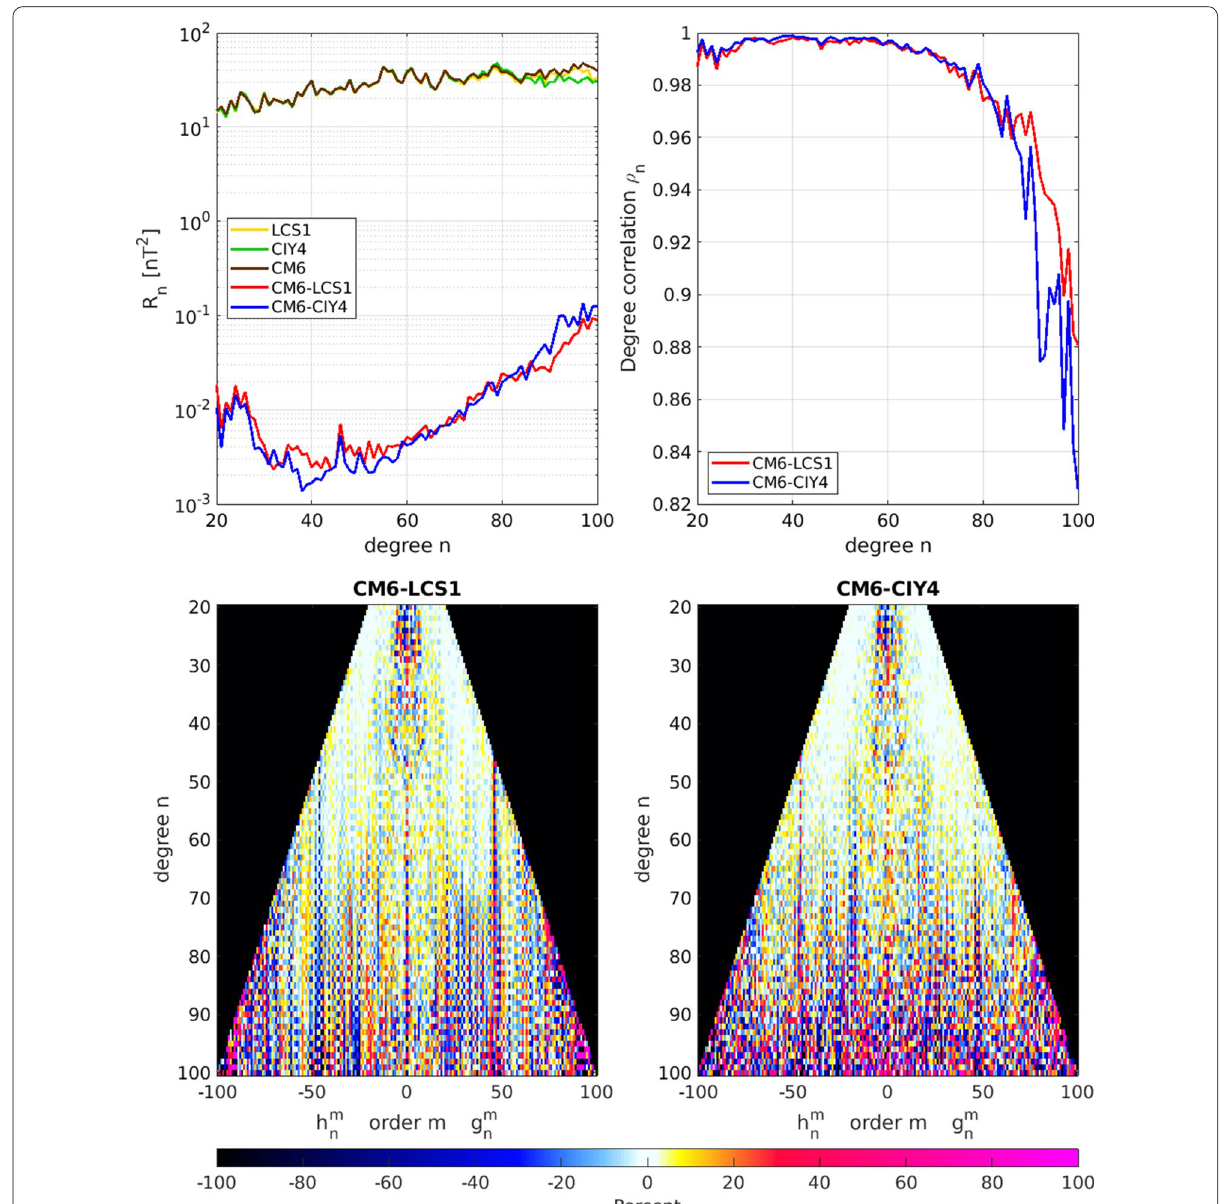
Fig. 5 The R n spectra (upper left) for LCS1, CIY4, and CM6 and the differences between CM6 and LCS1 and between CM6 and CIY4, the degree correlation, ρ n , (upper right) between CM6 and LCS1 and between CM6 and CIY4, and the normalized coefficient differences, S ( n , m ), of LCS1 (lower left) and CIY4 (lower right) with respect to CM6. All plots are for SH degrees n